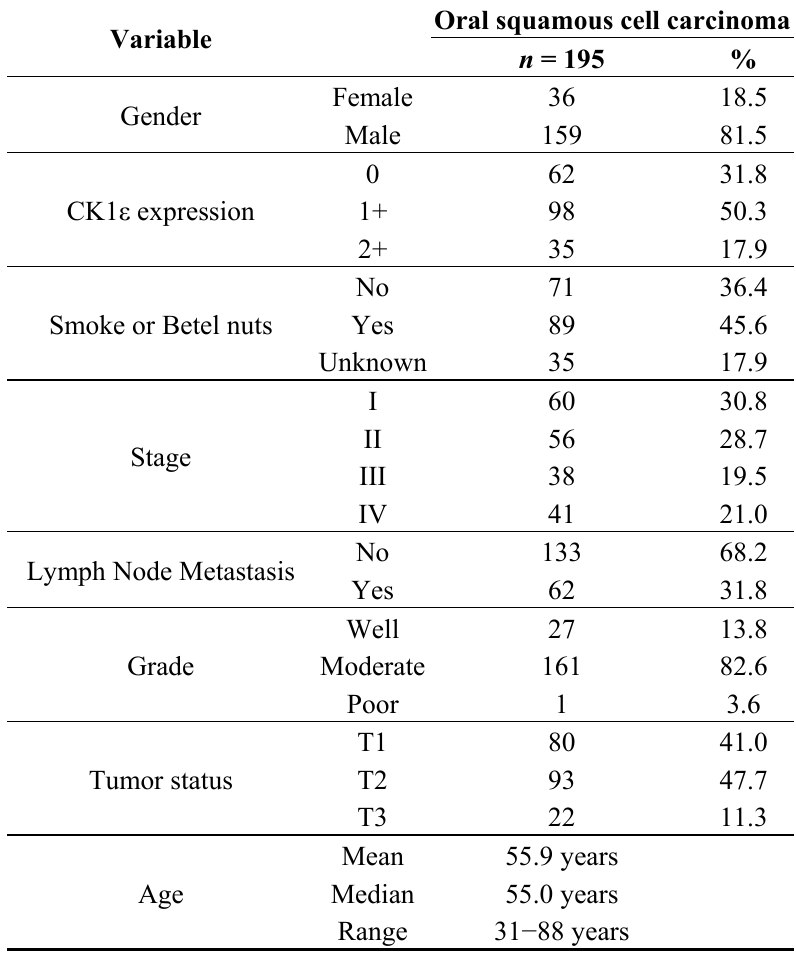
Table 1. Patient